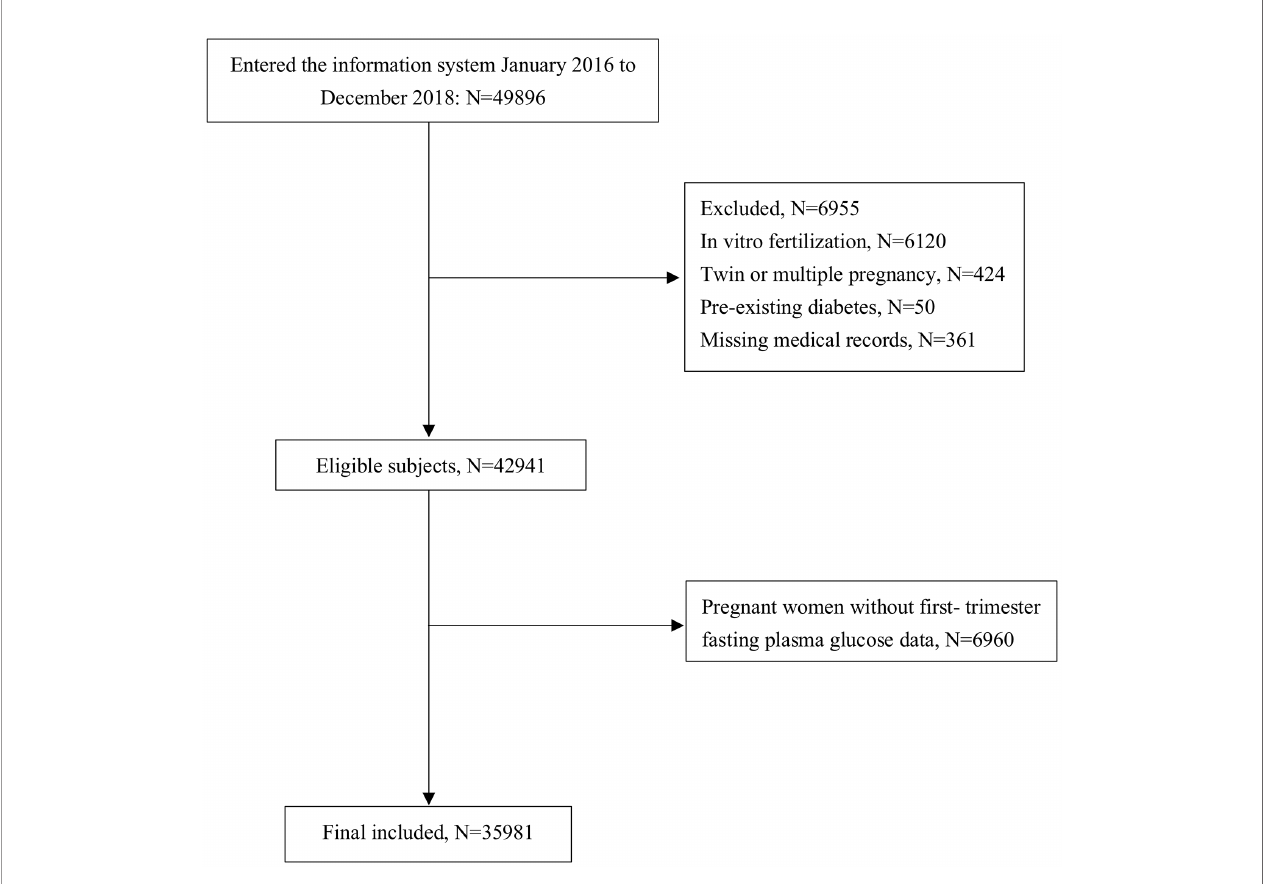
FIGURE 1 | Flowchart of the study